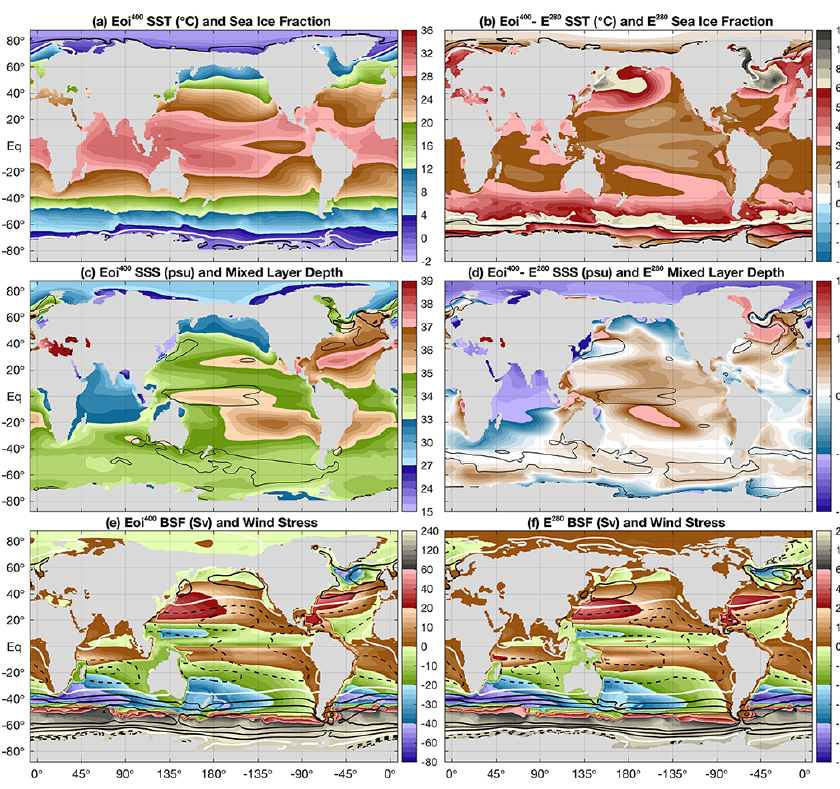
Figure 5. Annual mean oceanic model fields from our Eoi 400 case (a, c, e) and the Eoi 400 − E 280 difference: (a, b) sea surface temperature (shading) and sea ice fraction (contours; white: 0.15; black: 0.5 and 0.9). Contours in (a) show Eoi 400 , contours in (b) show E 280 . Panels (c, d) show sea surface salinity (shading) and mixed-layer depth (thin line: 100m; thick black line: 250m; thick white line: 500m). Panels (e, f) show the barotropic stream function (BSF; shading) and zonal wind stress (contours every 5 × 10 − 2 Pa; dashed: < 0; thick white line at 0hPa). Contours in (e) show Eoi 400 , and contours in (f) show E 280